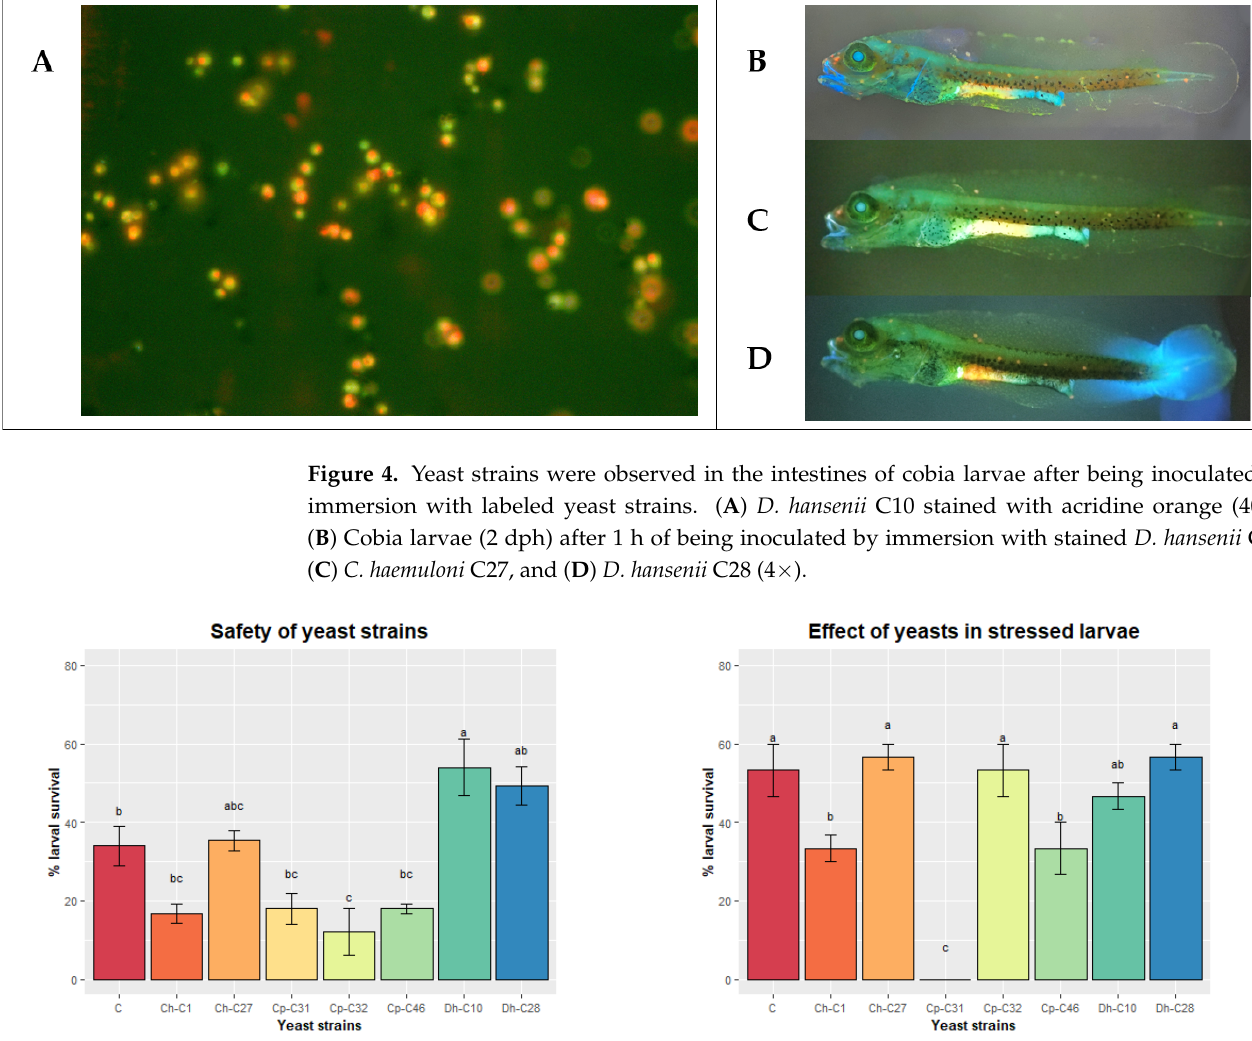
( C ) Figure 3. Polyamine production of yeast strains from the supernatants and cell pellets. ( A ) Total polyamines, ( B ) Spermine, and ( C ) Spermidine. The results are presented as the mean ± standard error. Ch, C. haemuloni ; Cp, C. parapsilosis ; Dh , D. hansenii ; Dsp, Debaryomyces sp.; Nsp, Naganishia sp. Different letters indicate significant differences ( p < 0.05) between yeast strains. Finally, we tested the safety of the yeast strains on cobia larvae. At 2 dph, larvae were inoculated by immersion with each yeast strain (10 7 CFU mL −1 ) for 24 h, and larval sur- vival was checked. All yeast strains entered the digestive tracts of the larvae, as fluores- cent yeasts stained with acridine orange were detected in their intestines at 1 h after im- mersion inoculation (Figure 4). C. parapsilosis C32 was associated with reduced larval sur- vival compared to the control group that was not inoculated with yeasts (Figure 5A). C. haemuloni C01 and C27, C. parapsilosis C31 and C46, and D. hansenii C28 did not affect survival. Interestingly, larvae inoculated with D. hansenii C10 showed a higher survival rate (54.0 ± 7.21%), 20% more than the control group, which was not inoculated with